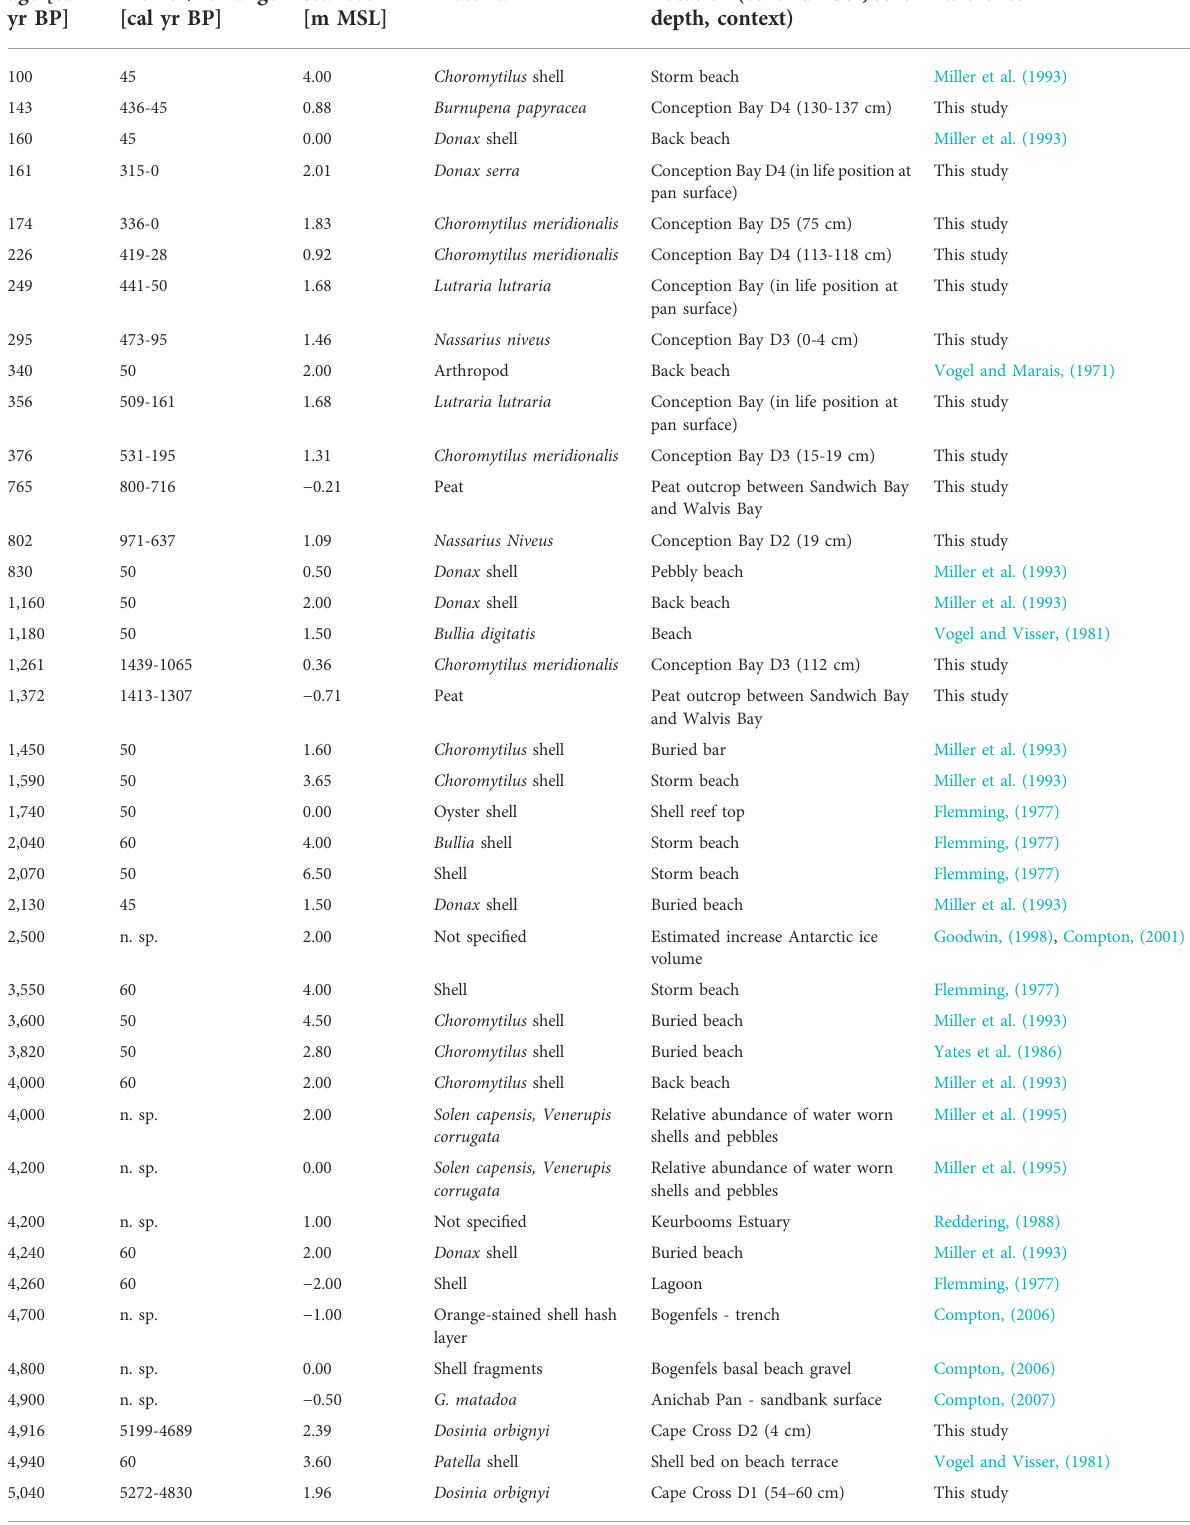
TABLE 3 Calibrated 14 C-ages and related sea level indicators along the Namibian coast based on this study and previously published